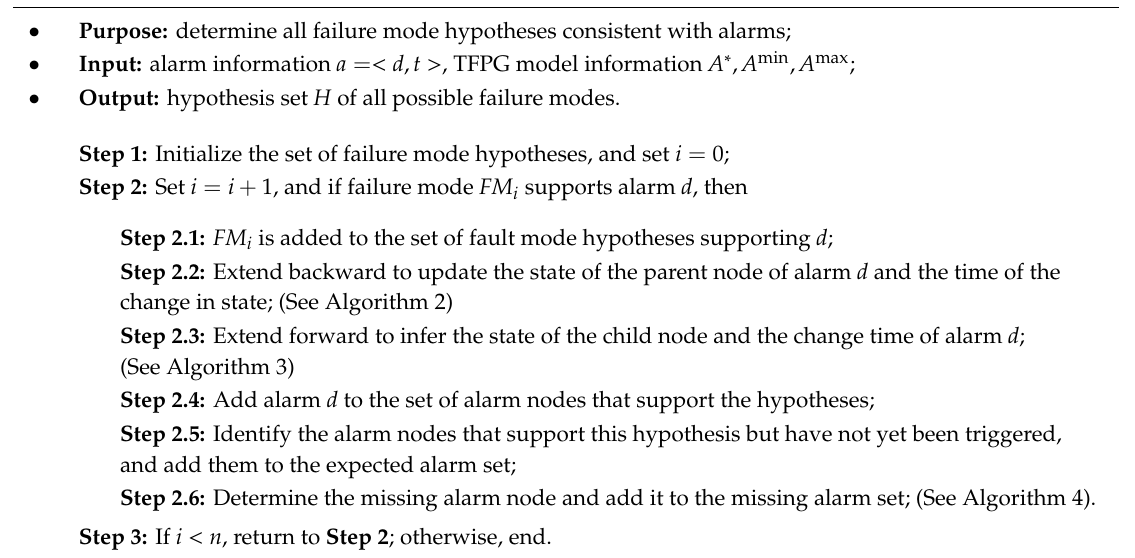
Algorithm 1. Hypothesis initialization algorithm based on alarm